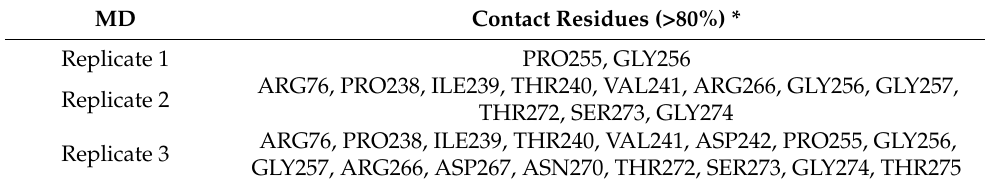
Figure 5. Relevant residues for PS2Aa1–APN interaction. Relevant residues for interacting with the APN receptor are displayed. GLY256, ARG76, ARG266, and SER273. PS2Aa1 and APN are colored blue and teal, respectively. Table 4. Residues in contact with APN